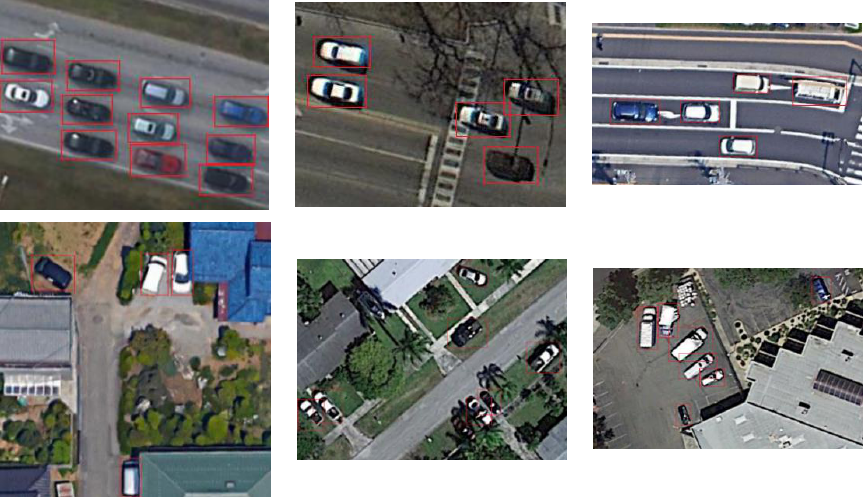
Figure 17. The detection results of partial pictures based on Multi-PerNet3.